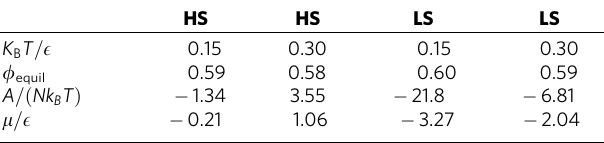
Table 2 | Thermodynamic